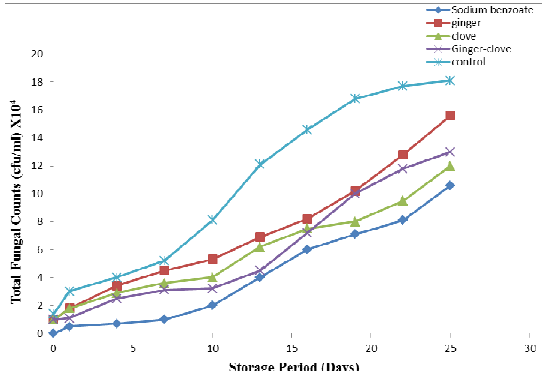
Fig. 6. Effects of different treatments at 5% concentration on the fungal counts of soymilk samples stored at refrigerated temperature for 25